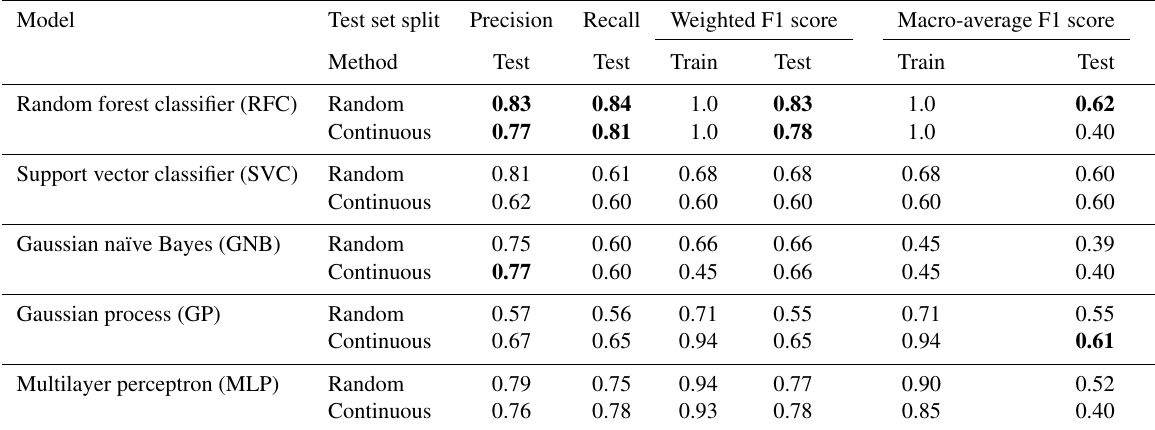
Table 5. Results for each model trained with the national dataset covering all of Finland (defined in Sect. 3.3). The results with boldfaced font represent the best achieved results within the metric, shown separately for the random and continuous split